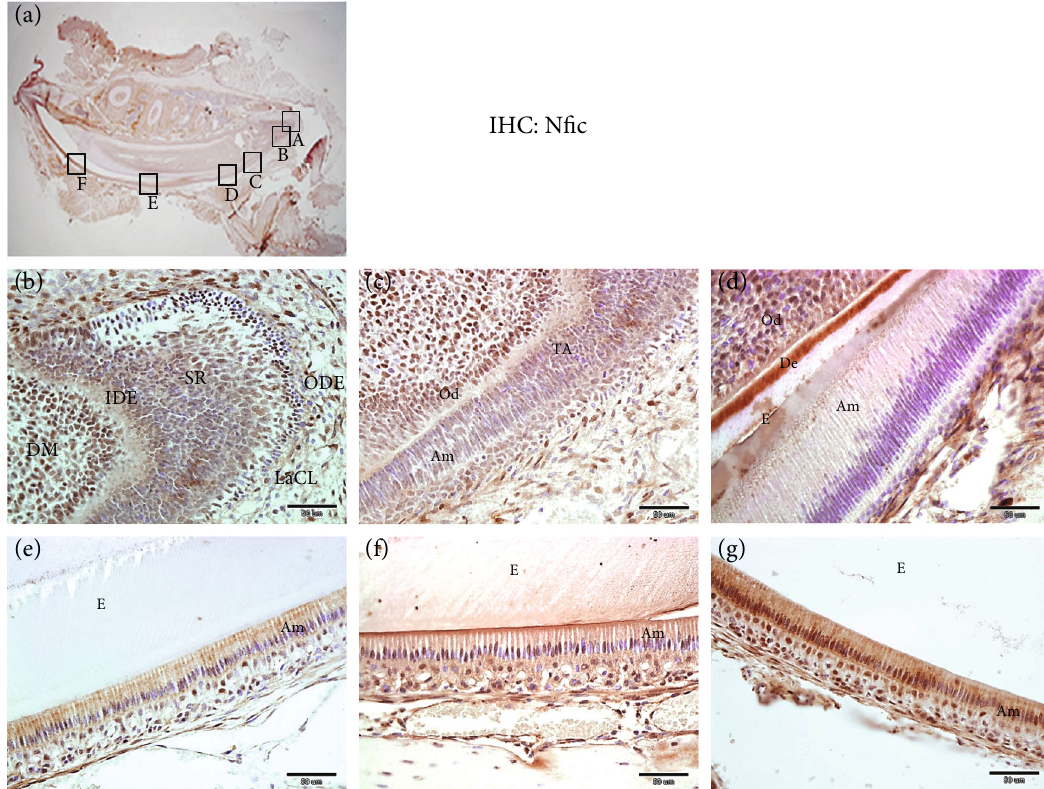
Figure 1: N fi c expression level decreases as DESC di ff erentiate into ameloblasts. (a) Immunohistochemistry (IHC) analysis of the sagittal section of a WT mandibular incisor is examined to observe the expression pattern of N fi c in the labial cervical loop. The histological analysis of the labial cervical loop shows the organized structure with DESCs di ff erentiating into ameloblasts towards the cervical loop of the incisor. (B) – (F) are higher magni fi cations of boxed (A), from right to left, respectively. (A) – (F) 6 weeks. Scale bars=(B) – (E) =50 μ m. (b – g) Illustrated diagram of the N fi c expression pattern and di ff erentiation level in the cervical loop of the mandibular